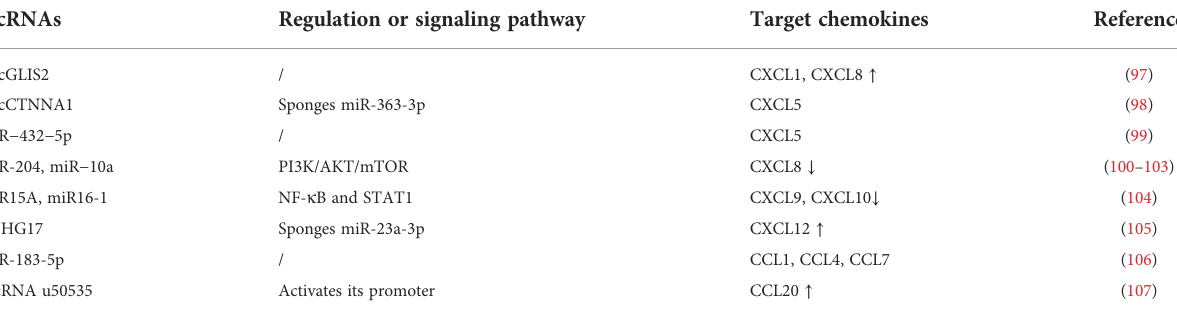
TABLE 1 ncRNA regulates the expression of chemokines in the CRC tumor cell and perform its recruitment or antitumor functions.